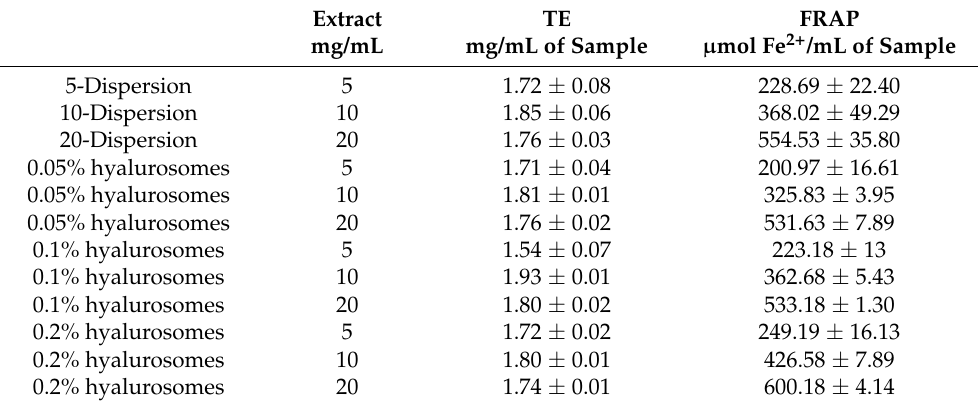
Table 3. Antioxidant activity of L. angustifolia extract in dispersion or loaded in hyalurosomes, expressed as Trolox equivalents (TE) and µ mol Fe 2+ (FRAP). Mean values ± standard deviations are reported ( n =